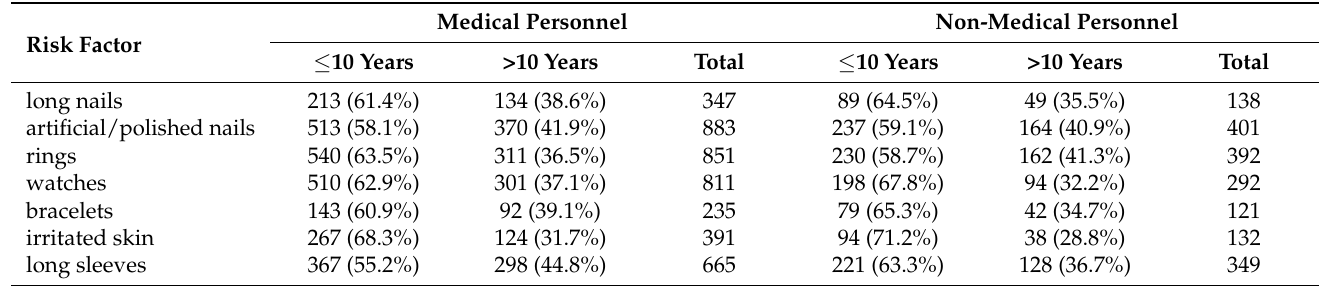
Table 5. Analysis of risk factors among participants who improperly prepared their hands for disinfection according to the participant’s job